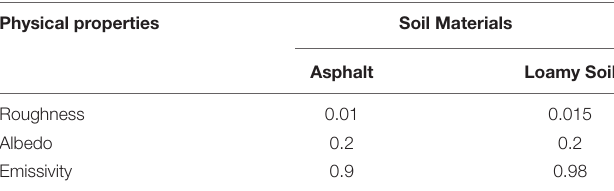
TABLE 3 | Physical properties of the soil materials used in the ENVI-met